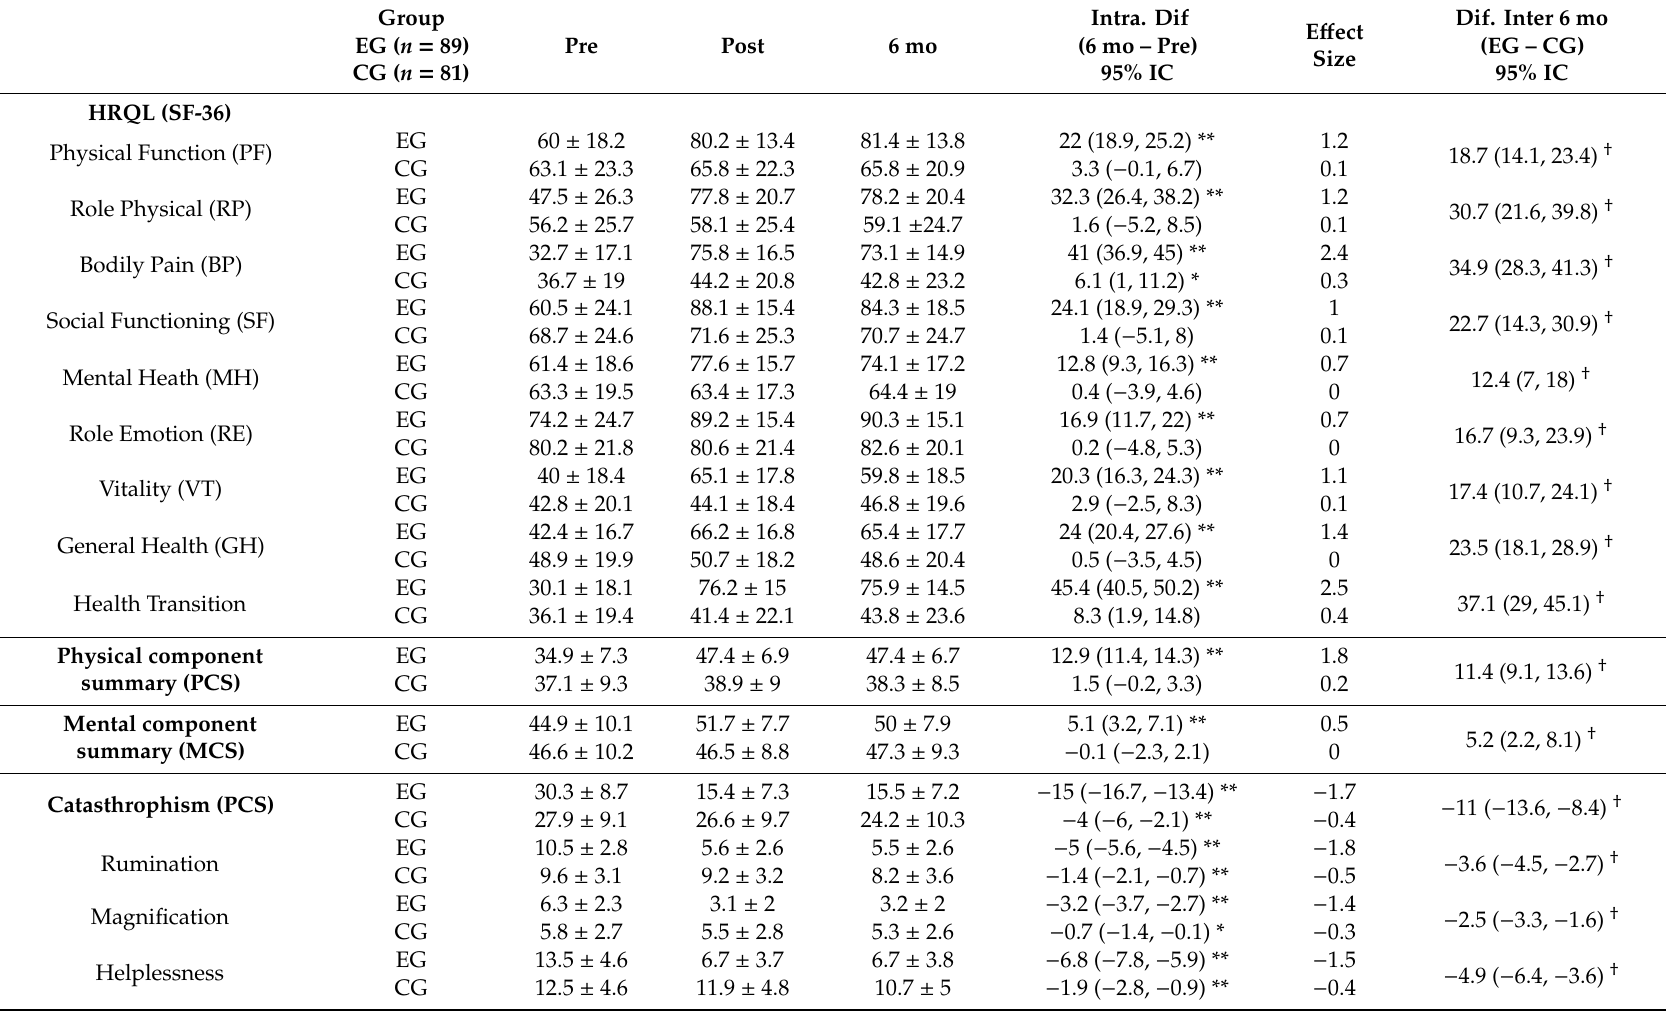
Table 2. Primary and secondary